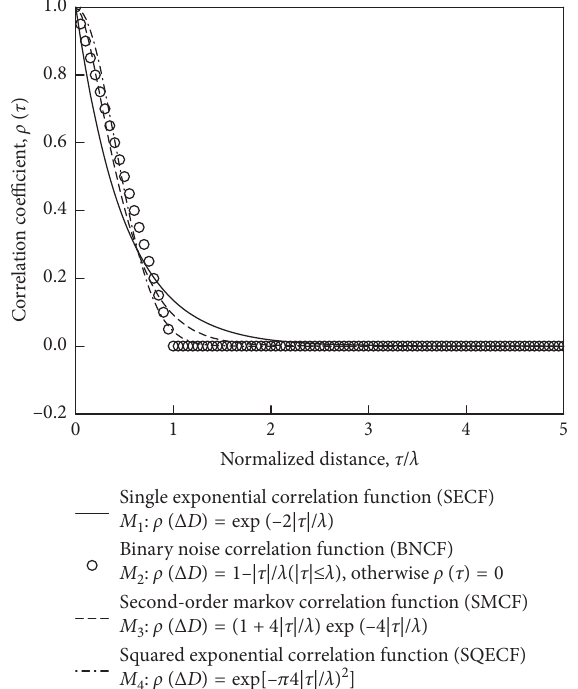
Figure 1: Four commonly used correlation functions in geo- technical engineering (after